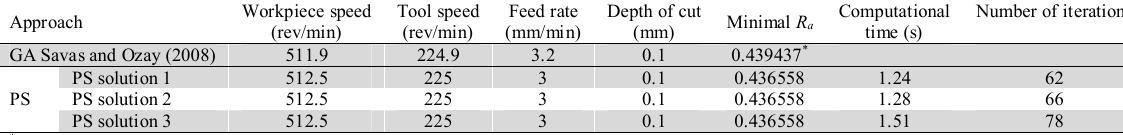
Comparison of optimization solutions for turn-milling machining process Tool speed Workpiece speed Approach (rev/min)